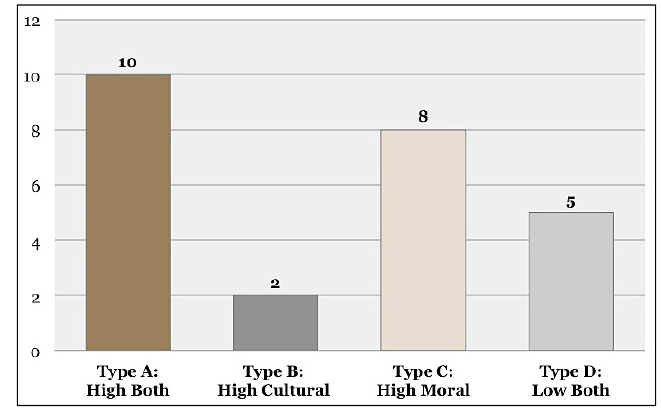
Figure 5. Typology Distribution for 2 ‐ Dimensional Framework.